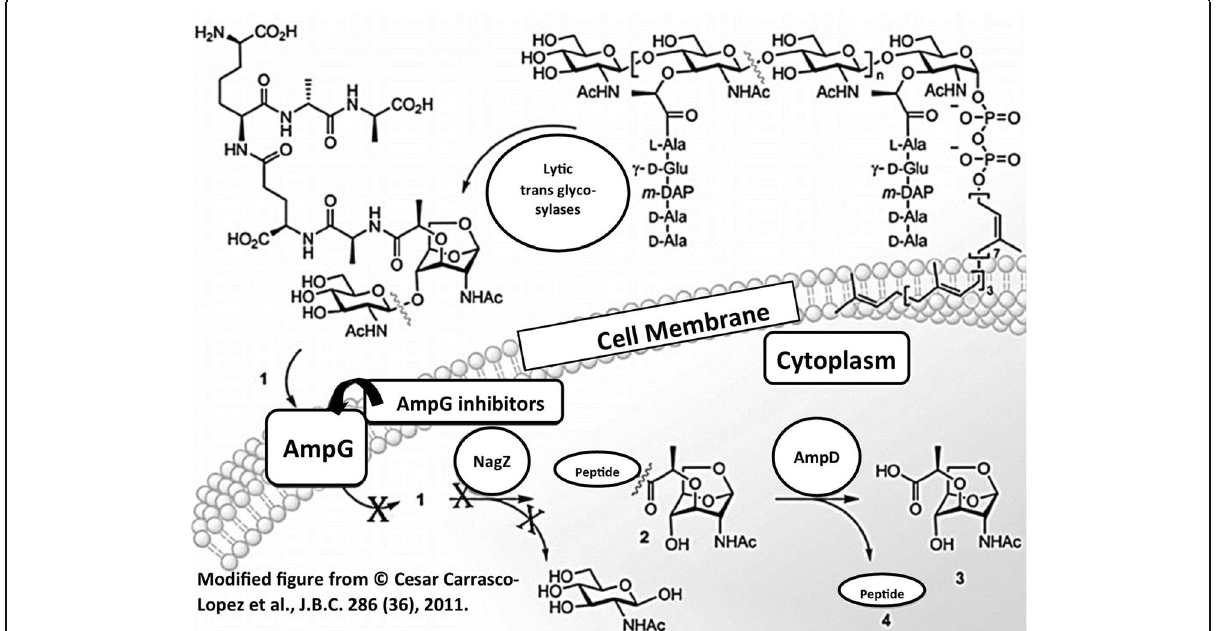
Fig. 11 Proposed mechanism for AmpG inhibitors which interfere in intracellular protein